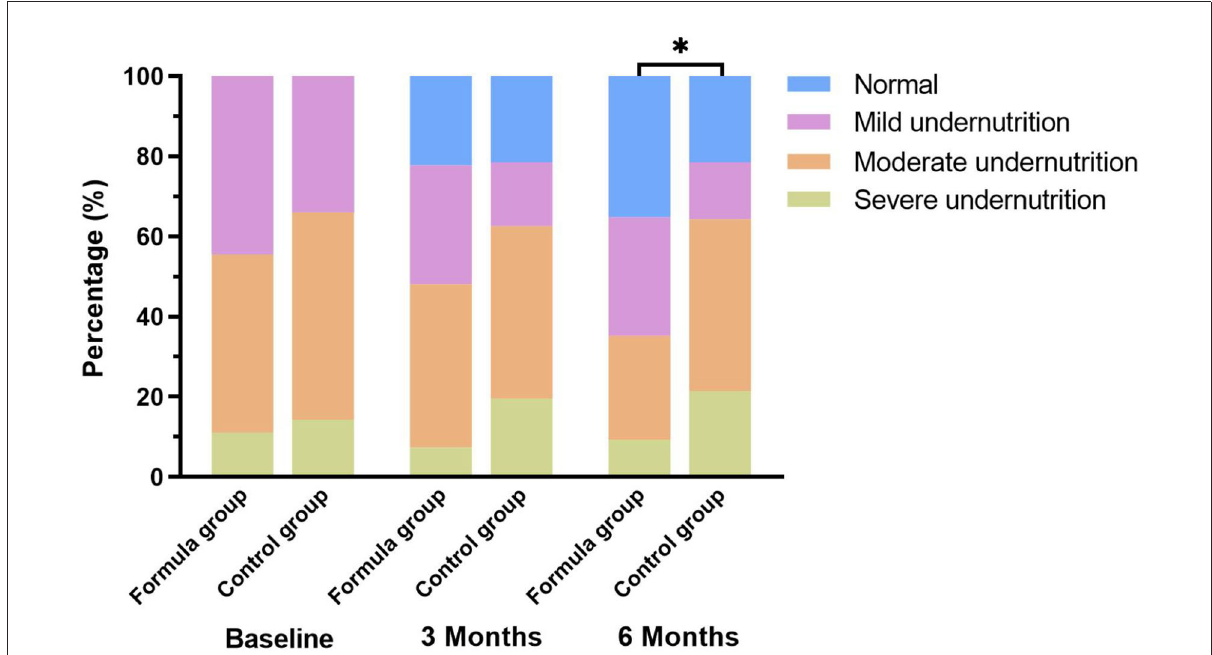
FIGURE2 Changes of nutritional classification among the study groups. * p < 0.05: significantly different in nutritional classifications between the two